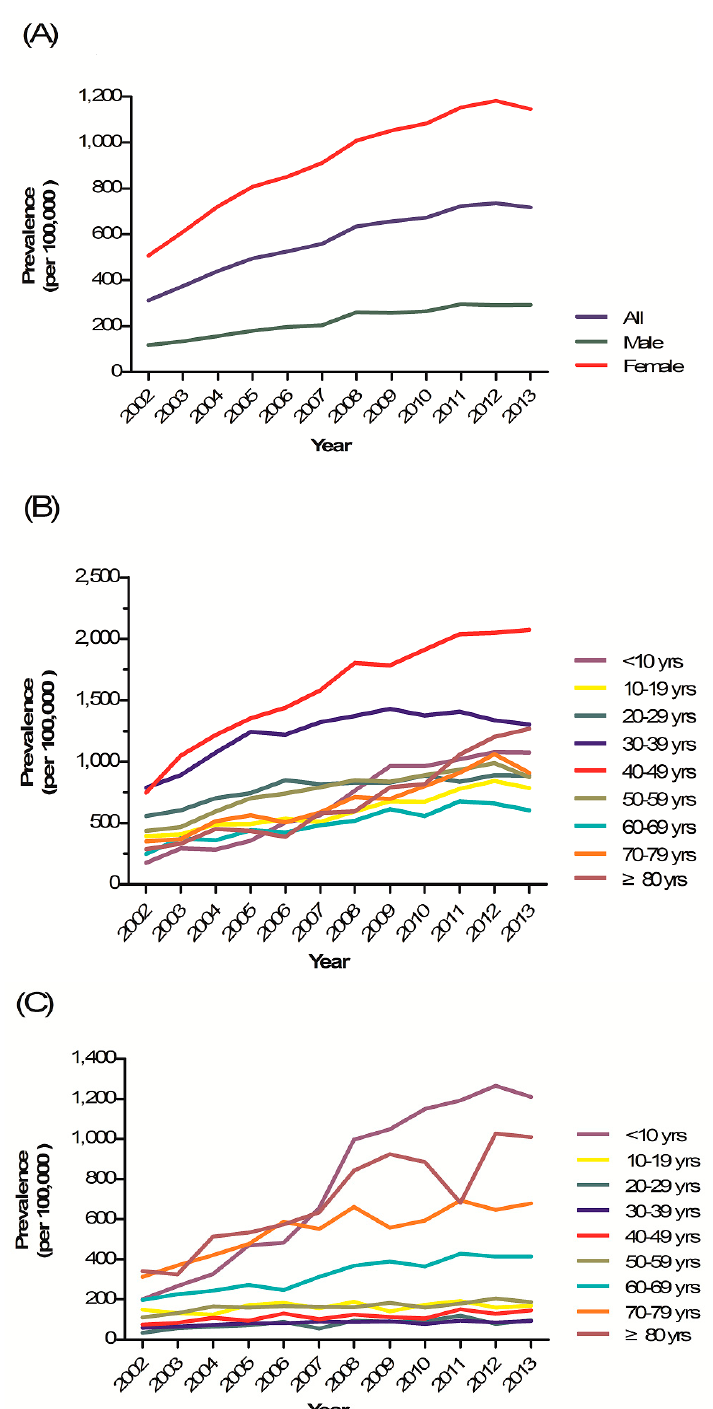
Figure 1. Tendency of iron deficiency anemia prevalence in Korea, 2002–2013. ( A ) Prevalence of iron deficiency anemia in the whole population. ( B ) Prevalence of iron deficiency anemia in females. ( C ) Prevalence of iron deficiency anemia in males.